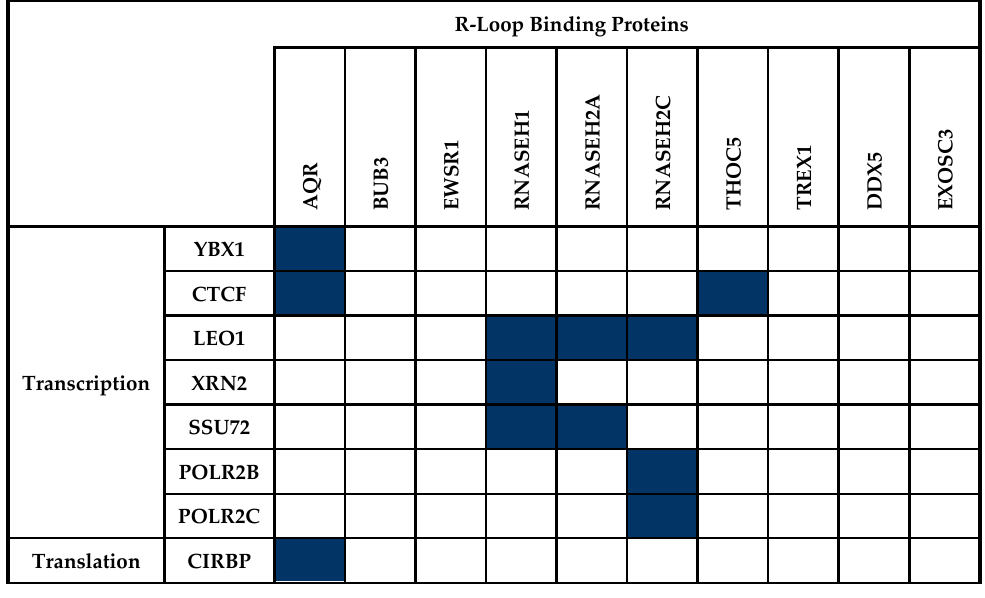
Table 2. Modulation of R-loop-binding or R-loop modifying proteins by components that control various aspects of gene expression including alternative polyadenylation (APA). Matrix of selected genes encoding R-loop-binding proteins ( x -axis) with significant alterations in polyadenylation after depletion of canonical and non-canonical 3 ′ end-processing factors ( y -axis—blue boxes indicate significant alterations in polyadenylation after depletion of canonical and non-canonical 3 ′ end-processing factors; y -axis—data obtained from TREND–DB [86] covering a large-scale screening [85] coupled to transcriptome-wide interrogation of alterations in polyadenylation by TREND-seq [89], further details in the text).